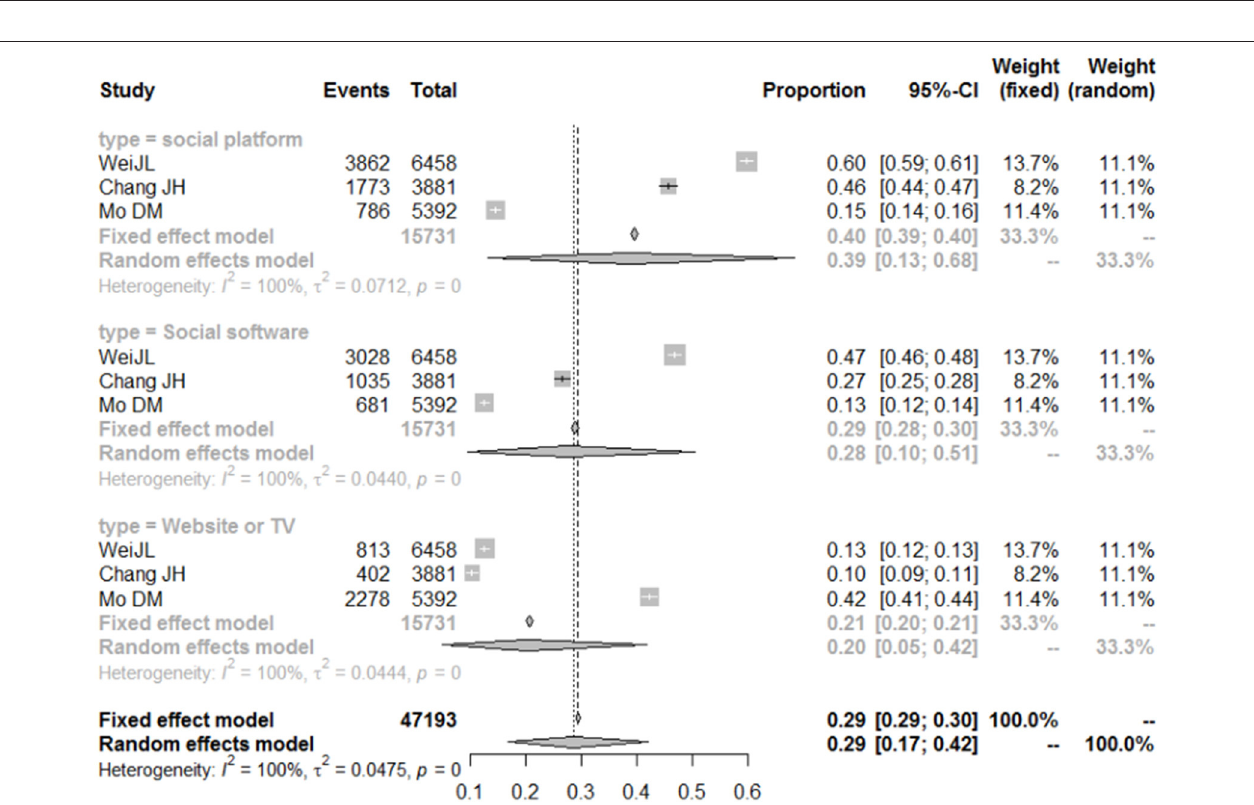
FIGURE 5 | Forest plot of the incidence of mild depression among college students during COVID-19.